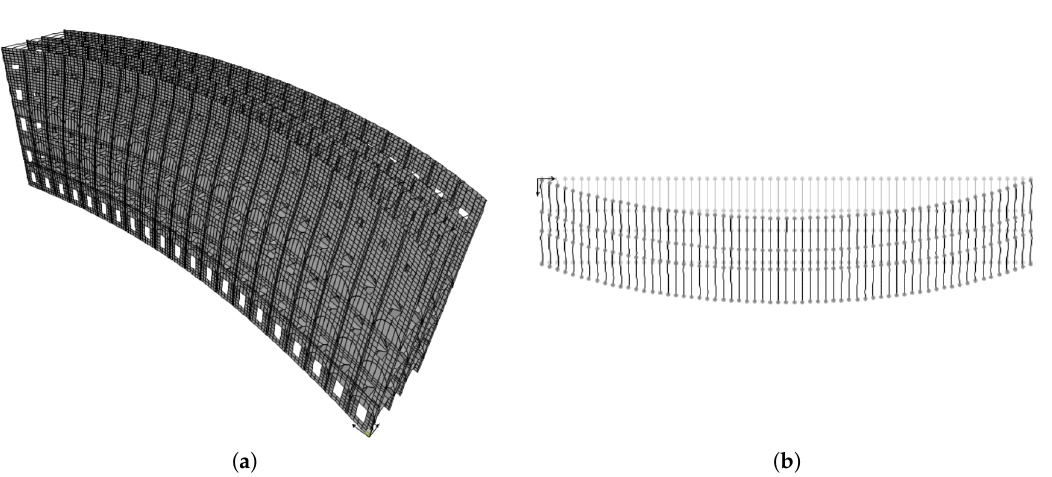
Figure 8. S x identification. Deformed configuration of the fine model in the: ( a ) 3D space; ( b ) x − z